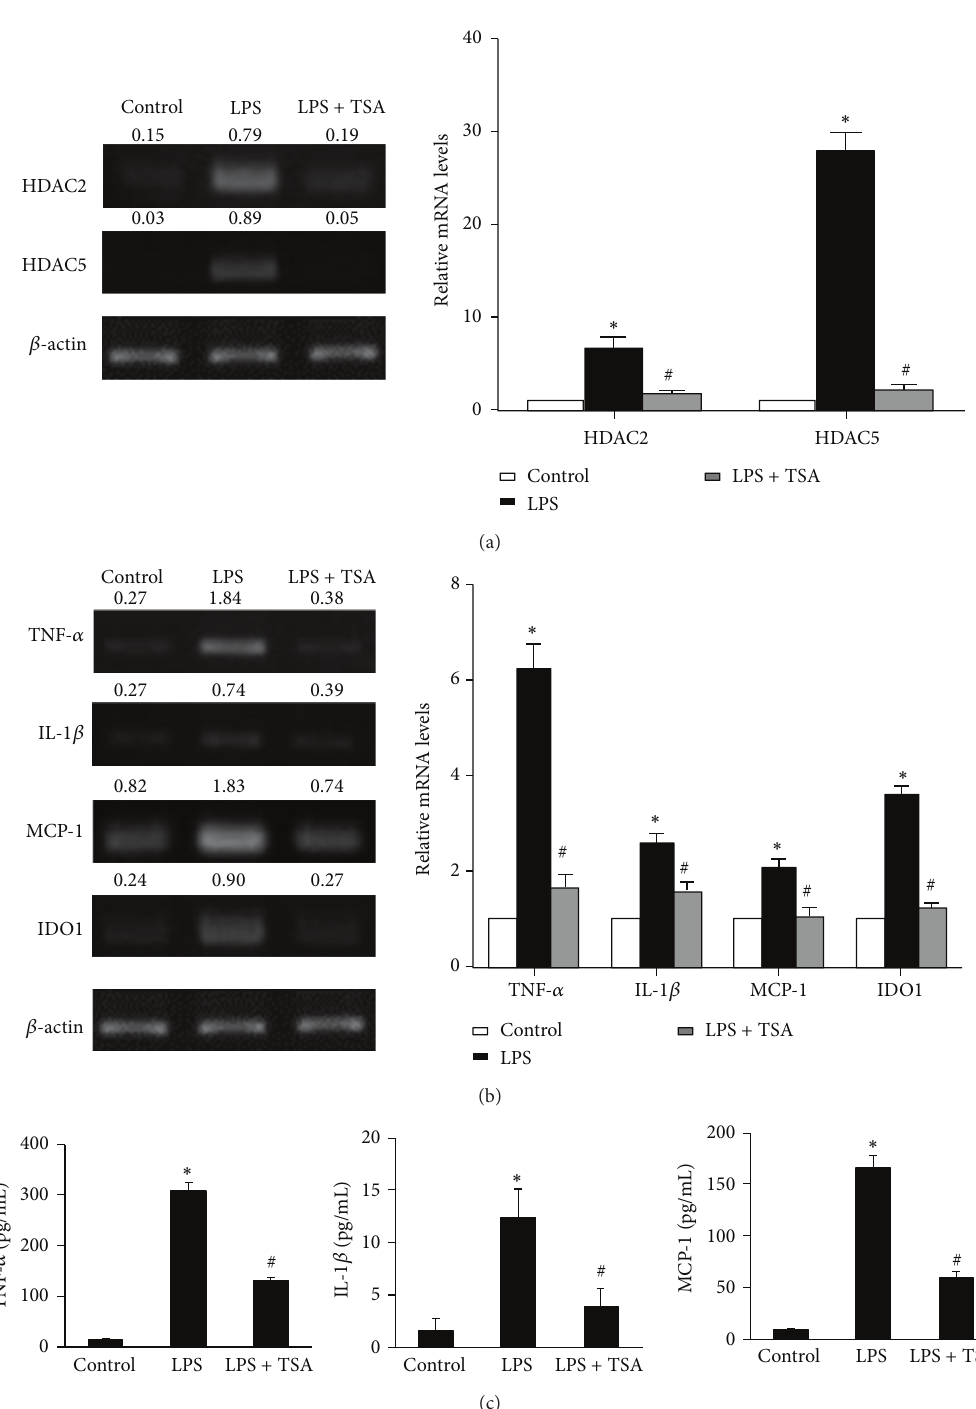
Figure 6: TSA reduced the LPS-induced mRNA expression levels of HDACs and cytokines in BV-2 cells. One hour after BV-2 cells had been pretreated with saline or TSA (10ng/mL), they were treated with saline or LPS for 4 hours as indicated. (a) HDAC2 and HDAC5 and (b) TNF- 𝛼 , IL-1 𝛽 , MCP-1, and IDO mRNA expression were determined using RT-PCR. The right panel shows the quantification of mRNA expression from three independent experiments. (c) The protein levels of TNF- 𝛼 , IL-1 𝛽 , and MCP-1 in supernatants of the cultured BV-2 cells were determined using ELISA. Data are means ± SEM ( 𝑛 = 3 in each group). ∗ 𝑃 < 0.05 compared with the Control group; # 𝑃 < 0.05 compared with the LPS-only